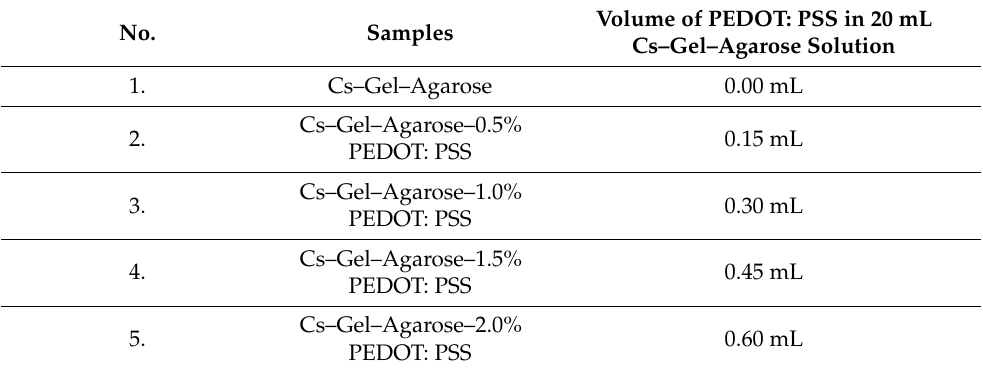
Table 1. List of samples and the amount of PEDOT: PSS required for each 20mL Cs–Gel–Agarose solution. Volume of PEDOT: PSS in 20 No. Samples